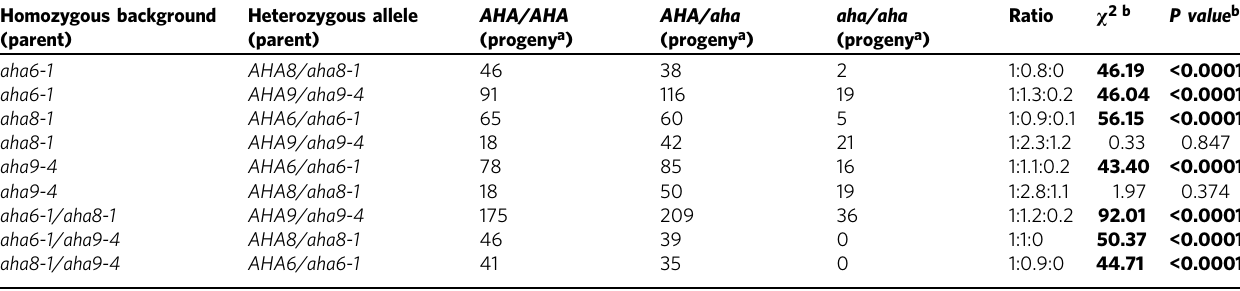
Table 1 Offspring of self-pollinated lines exhibit a non-Mendelian pattern of inheritance. Homozygous background